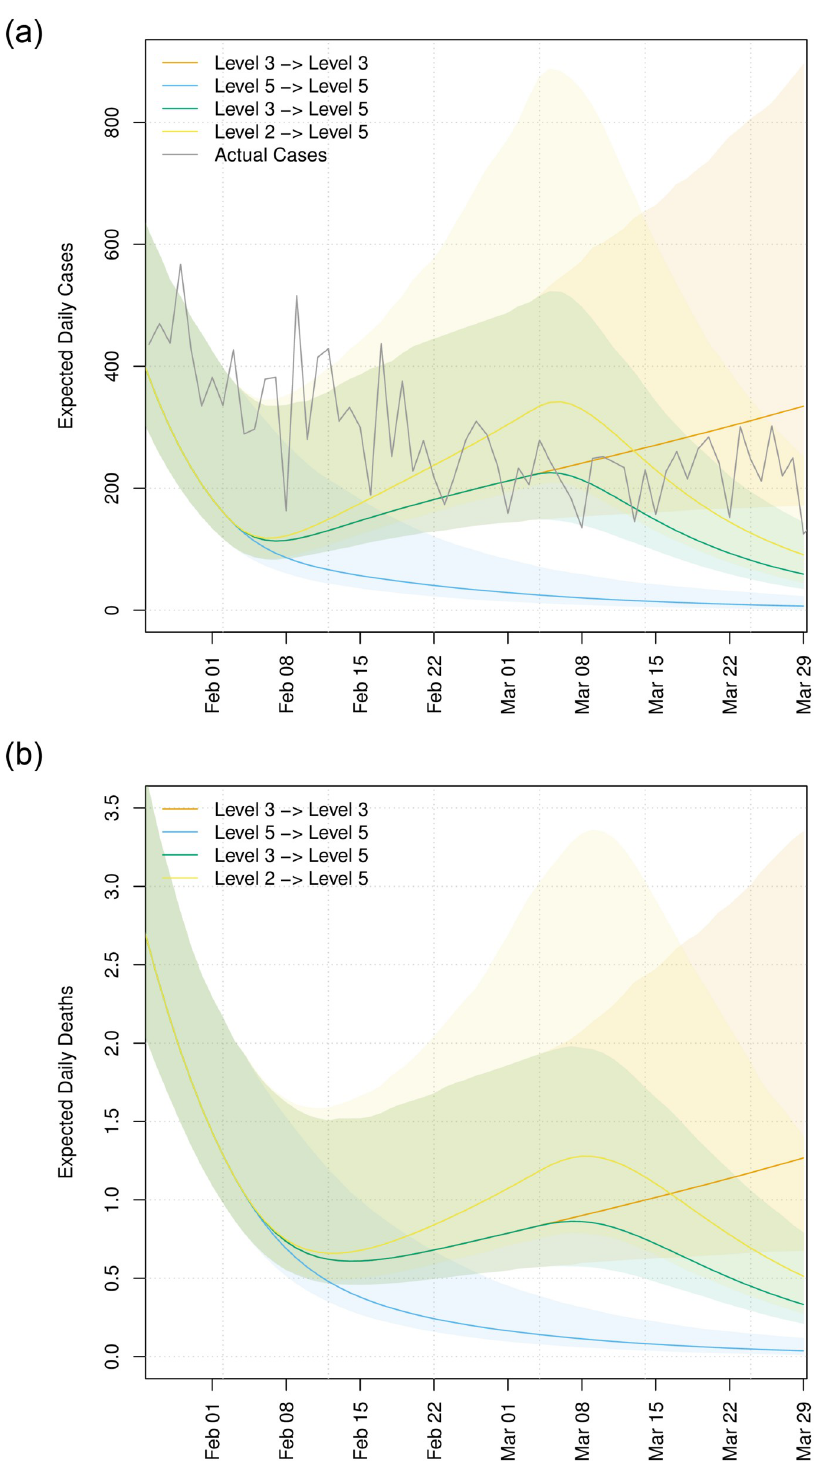
Fig 10. Projected infection rates and deaths under different lockdown scenarios. The death data is not available for the Dublin region for this period.